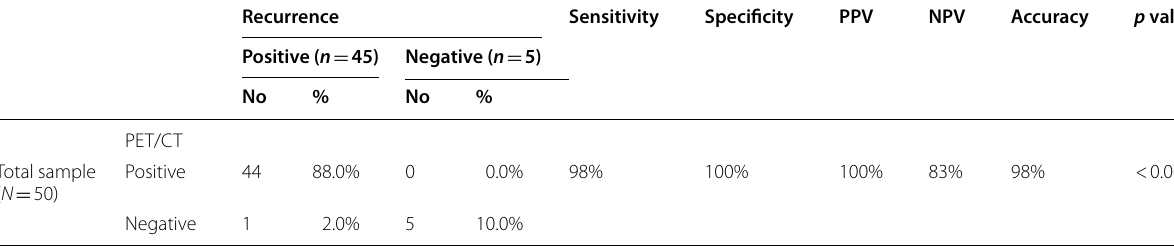
p p value of Fisher s test